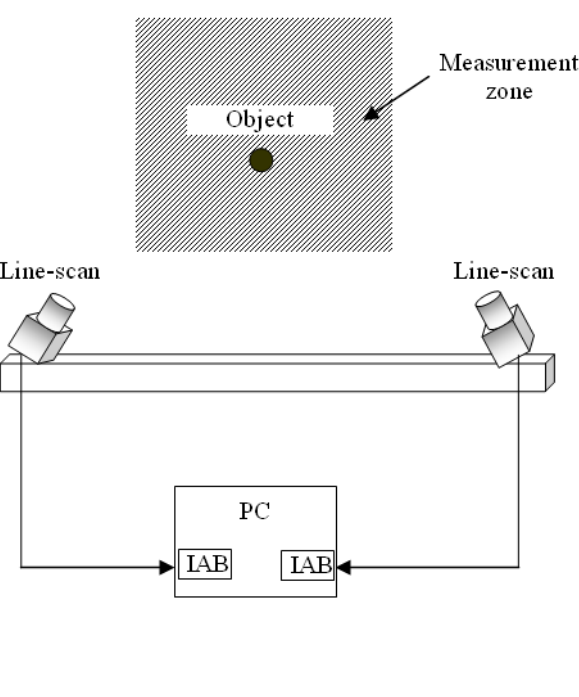
Figure 1. Block diagram of 2-D sensor system.